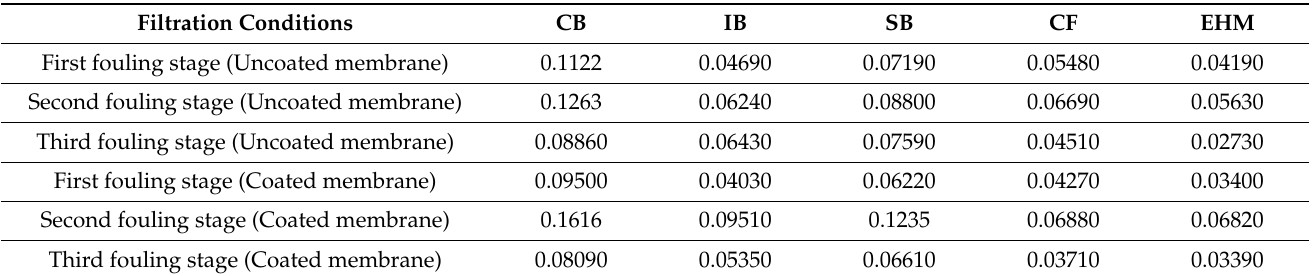
Table 15. RMSE results obtained in Example 5.